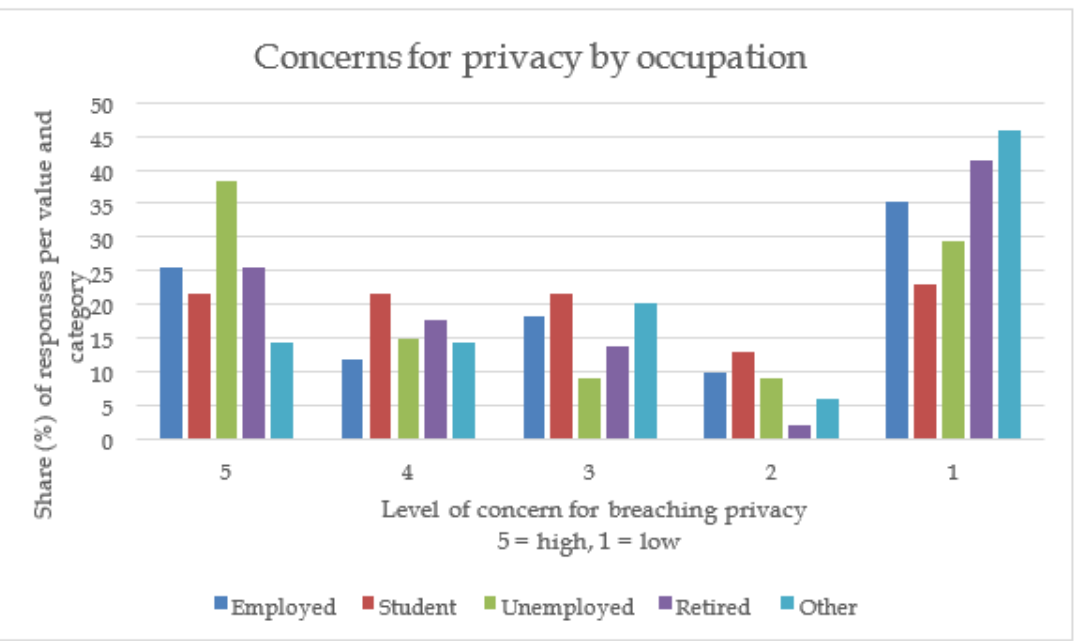
Figure 3. Concern about breaching privacy and occupation. Percentage per reported value on scale 5-1. Employed n=94 (100%), Student, n=70 (100%), Unemployed n=34 (100%), Retired n=51 (100%), Other n=35 (100%). Total